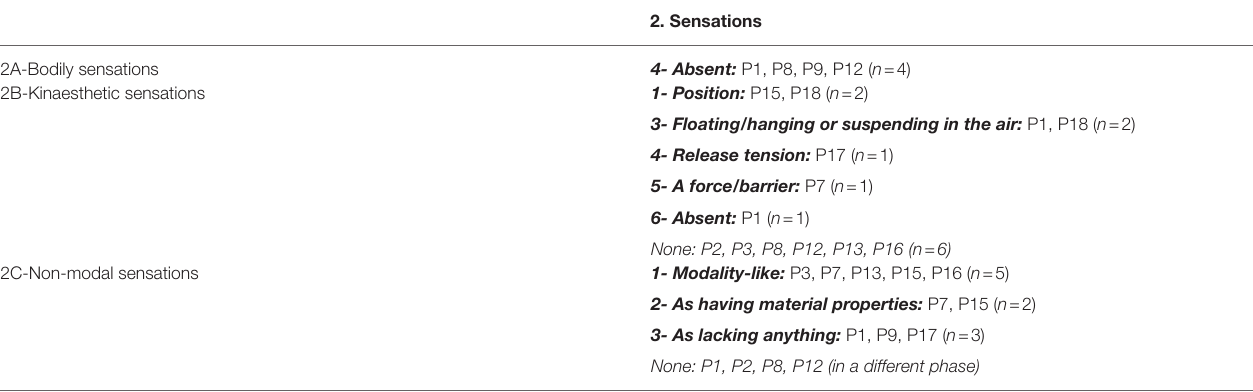
TABLE 6 | Second- and third-level categories and the participants identified for each for the first-level category Sensations.